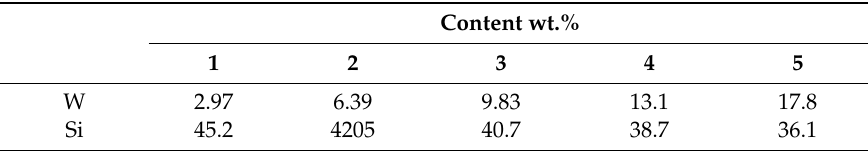
Table 4. Composition of